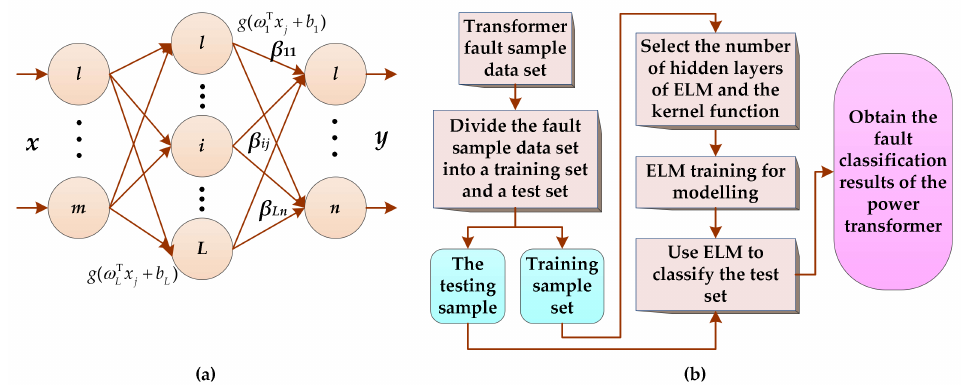
Figure 13. Illustration of ELM, among which ( a ) is the ELM network structure; and ( b ) shows the ELM-based transformer fault diagnosis flow